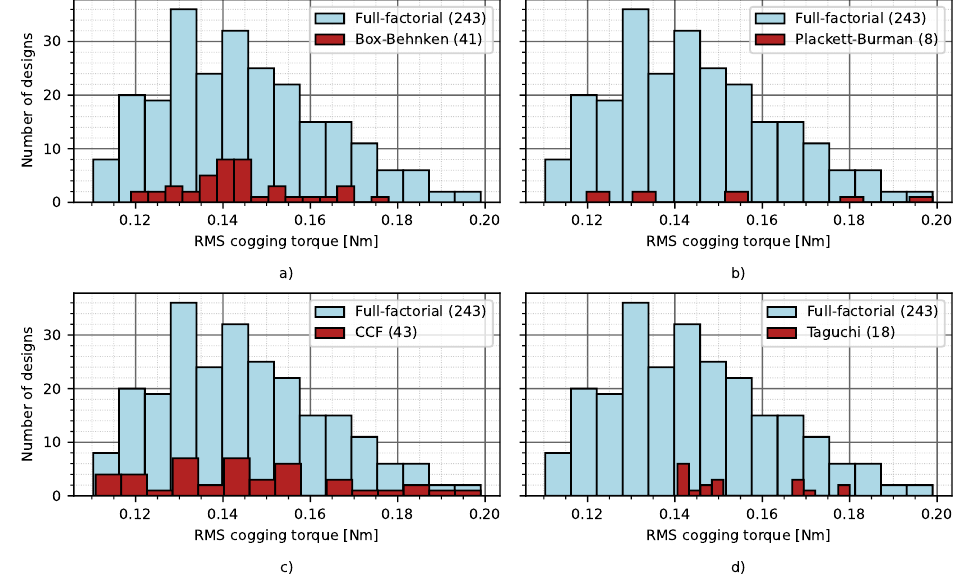
Figure 15. The distribution of the calculated rms value of the cogging torque with the different Doe strategies: Box-Behnken ( a ), Plackett-Burman ( b ), CCF ( c ), and Taguchi ( d ), which were compared with the Full-factorial